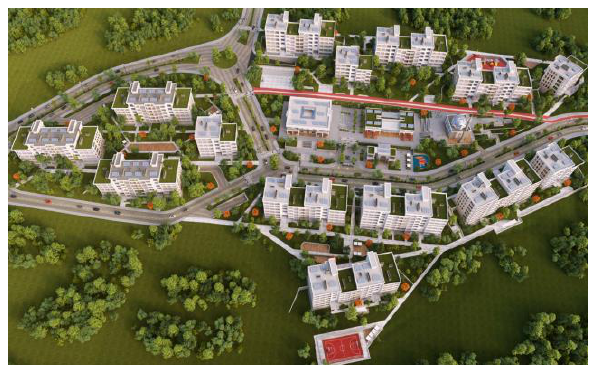
Figure 1. An overview of the developed smart city concept (MoEU,